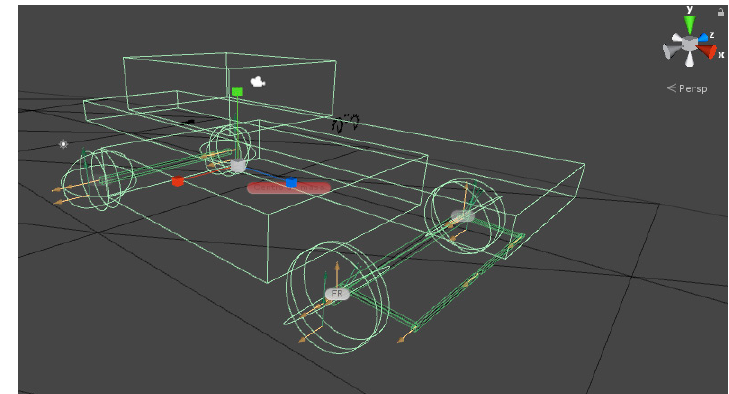
Figure 1. Elements of the virtual automobile.